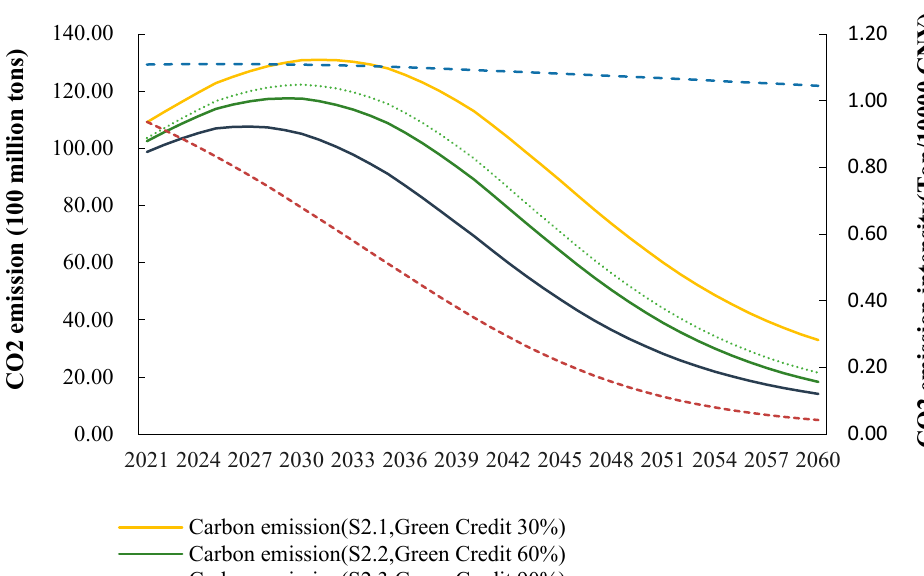
Figure 7. Change in CO 2 emissions and intensity, 2020–2060, China.